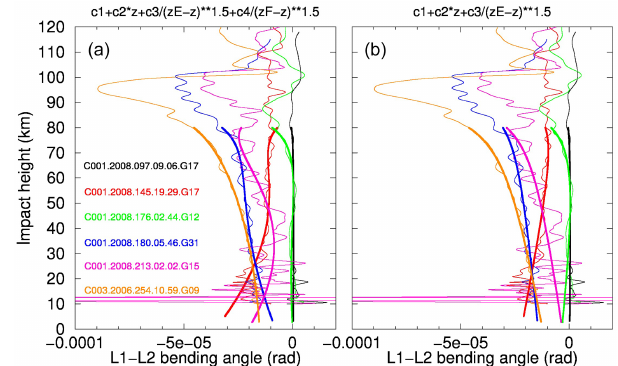
Figure 2. Left panel: examples of electron density profiles modeled by Chapman layer. Blue lines: F2 layer at 300km with vertical scale 50km (dashed line) and 75km (solid line). Green lines: E layer at 100km with vertical scale 5km (dashed line) and 7.5km (solid line). Right panel: L1–L2 bending angles obtained by ray tracing for the profiles in left panel (blue and green lines); approximations by bending angles calculated for refractivities modeled by delta func- tions at 300 and 100km (red lines). Numbers (%) show fractional rms deviations (averaged below 20km) between L1–L2 bending an- gles and their approximations.